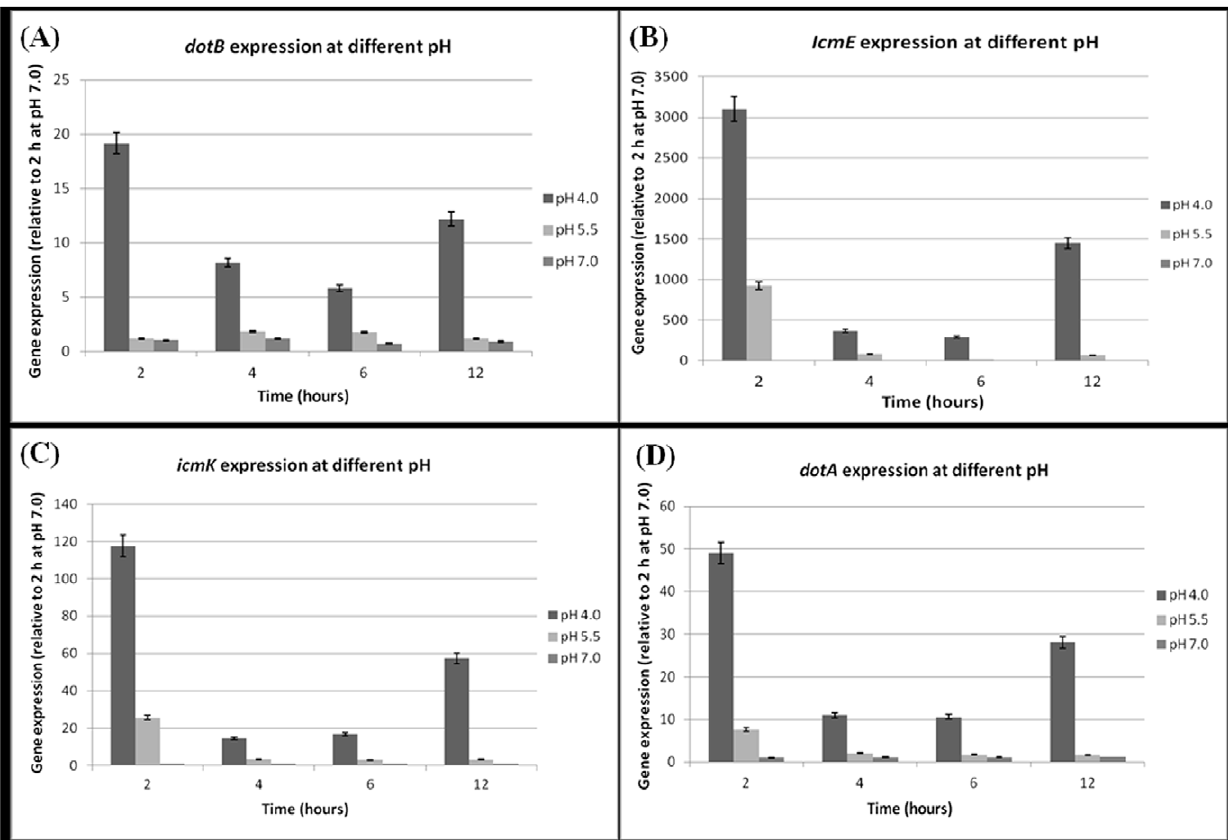
Figure 3. Expression profiles of dot/icm genes throughout P.salmonis growth kinetics at different pHs in MC1 medium. Gene expression was determined by qRT-PCR, using relative quantification. A: dotB gene expression number; B: icmE gene expression; C: icmK gene expression; D: dotA gene expression. Gene expression was normalized by the use of ITS like a housekeeping gene. Two hours of growth at pH 7.0 was used as calibrator (value=1) for all genes. The figure shows that all genes were notably over-expressed at pH 4.0, particularly at 2 hours of incubation.